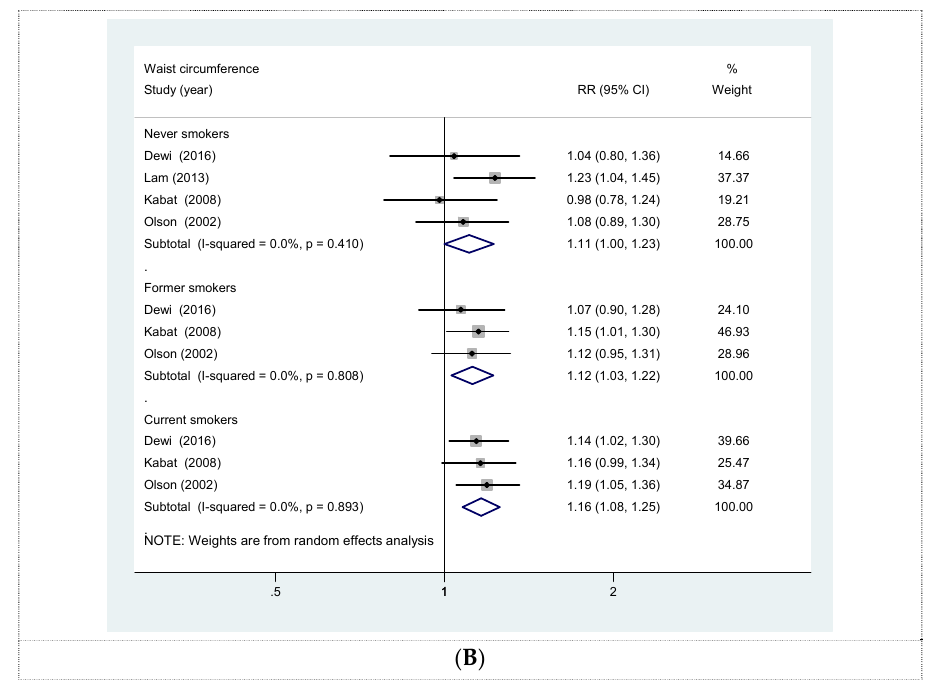
Figure 2. ( A ) Forest plot for linear dose ‐ response analysis on waist circumference and lung cancer risk, per 10 cm increase. All risk estimates for waist circumference were additionally adjusted for body mass index (BMI); ( B ) forest plot for linear dose ‐ response analysis on waist circumference and lung cancer risk stratified by smoking status. CI confidence interval; RR relative risk.